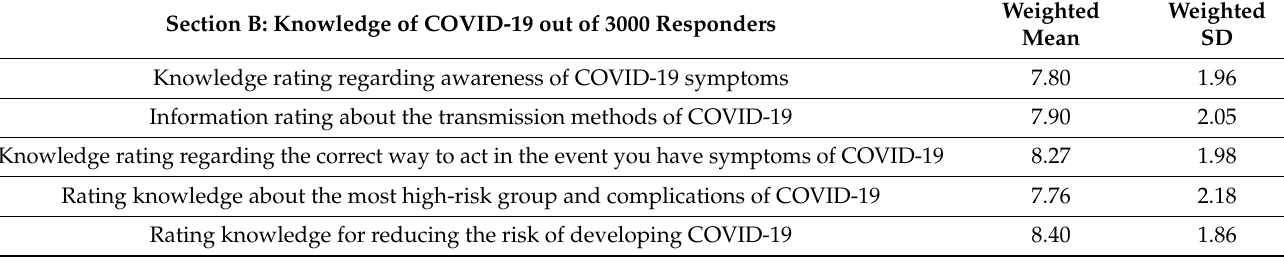
Table 2. Knowledge levels of the respondents regarding COVID-19 (N = 3000). Section B: Knowledge of COVID-19 out of 3000 Responders